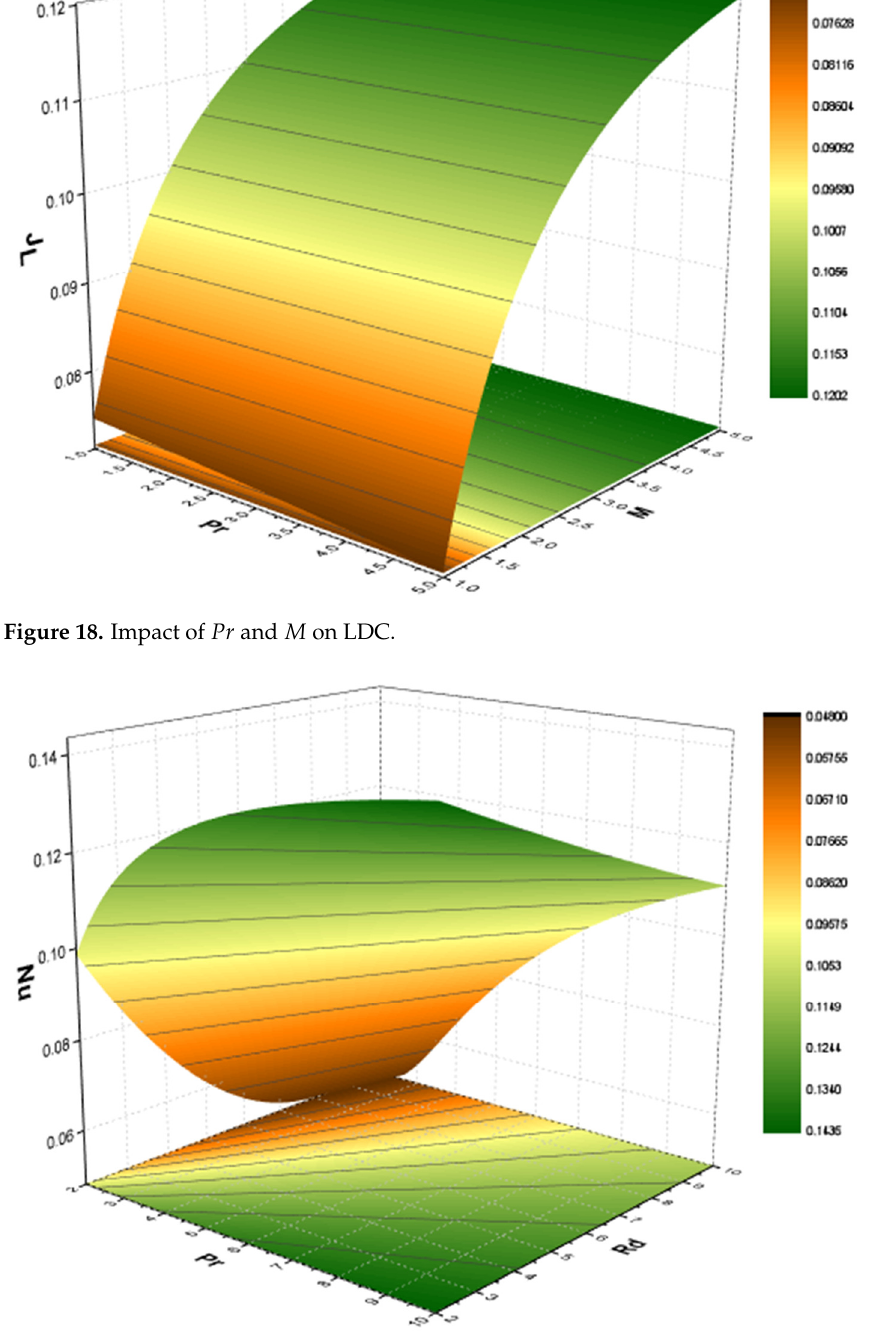
Figure 19. Impact of Pr and R d on NN.